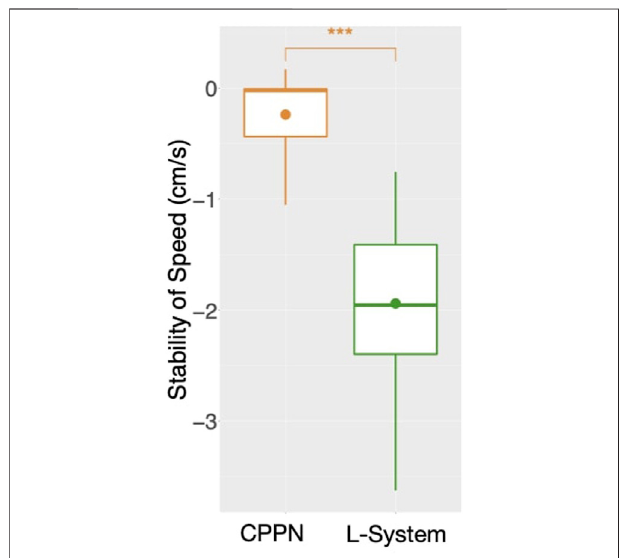
FIGURE 8 | Average stability of speed among runs: for each run, includesallrobotsofthe fi nalgeneration(149)aggregatedusingthemedian.A marker above boxes represents a p < 0.001 for a Wilcoxon